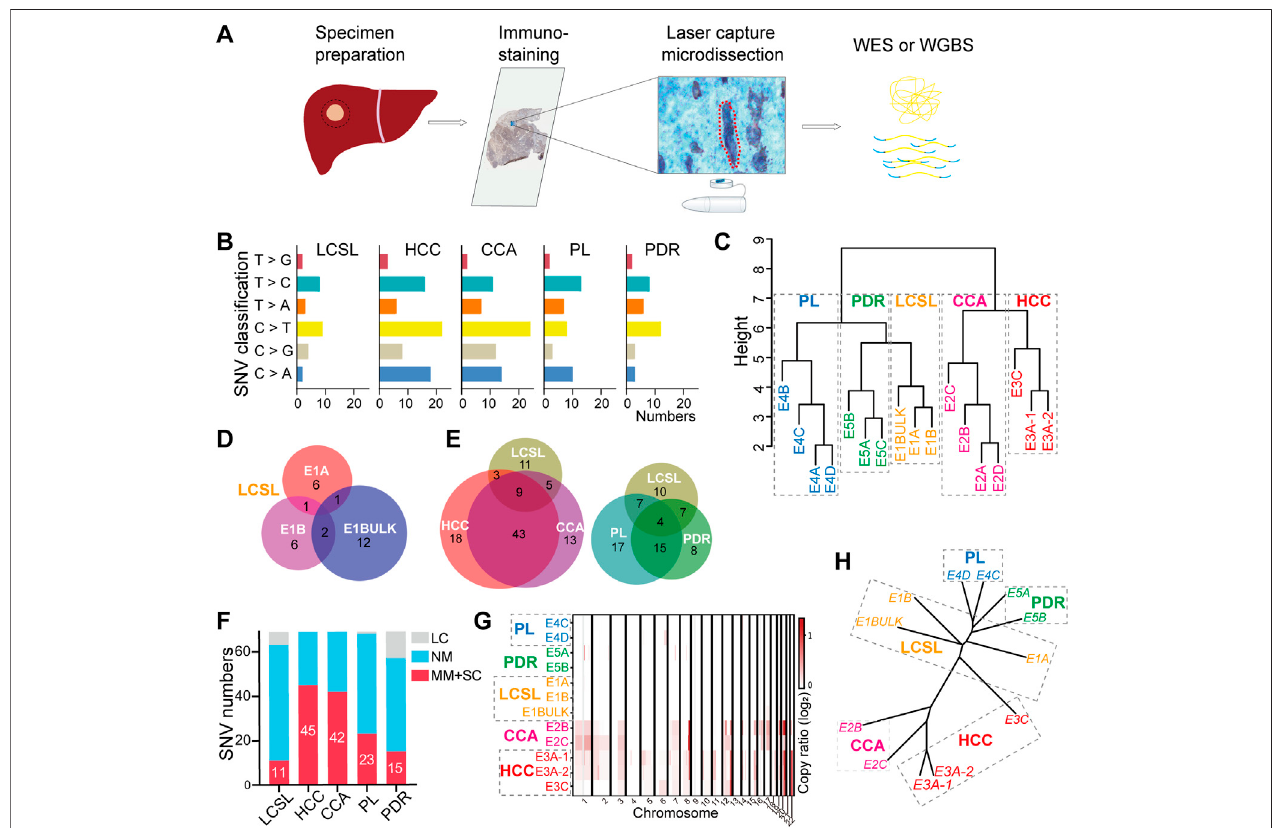
FIGURE2| SubstantiallyfewergeneticchangesinLCSLcellsthaninHCCandCCAcells. (A) ExperimentaldesignandtheCIL-seqmethoddevelopedinthisstudy ( see also MaterialsandMethods ). (B) MutationcharacteristicsofdifferentcelltypesfromP2. (C) SNVclusteranalysisofthe16sequencingsamplesfromP2. (D) Venn diagramsshowtheSNVssharedamongdifferentsamplesofLCSLcells. p -valuefortheoverlappingwascalculatedbyhypergeometricdistributiontest. p > 0.05inthree pairwisecomparisons. (E) VenndiagramsshowtheSNVoverlapbetweenLCSLcellsandothertypesofcells. p > 0.05inallpairwisecomparisons,but p < 0.001in HCC vs. CCA. (F) The number of missense mutations (MM) and stop codon changes (SC) identi fi ed in different cell types. LC, low coverage; NM, no mutation. (G) Heatmapshowsthedistributionpatternofampli fi